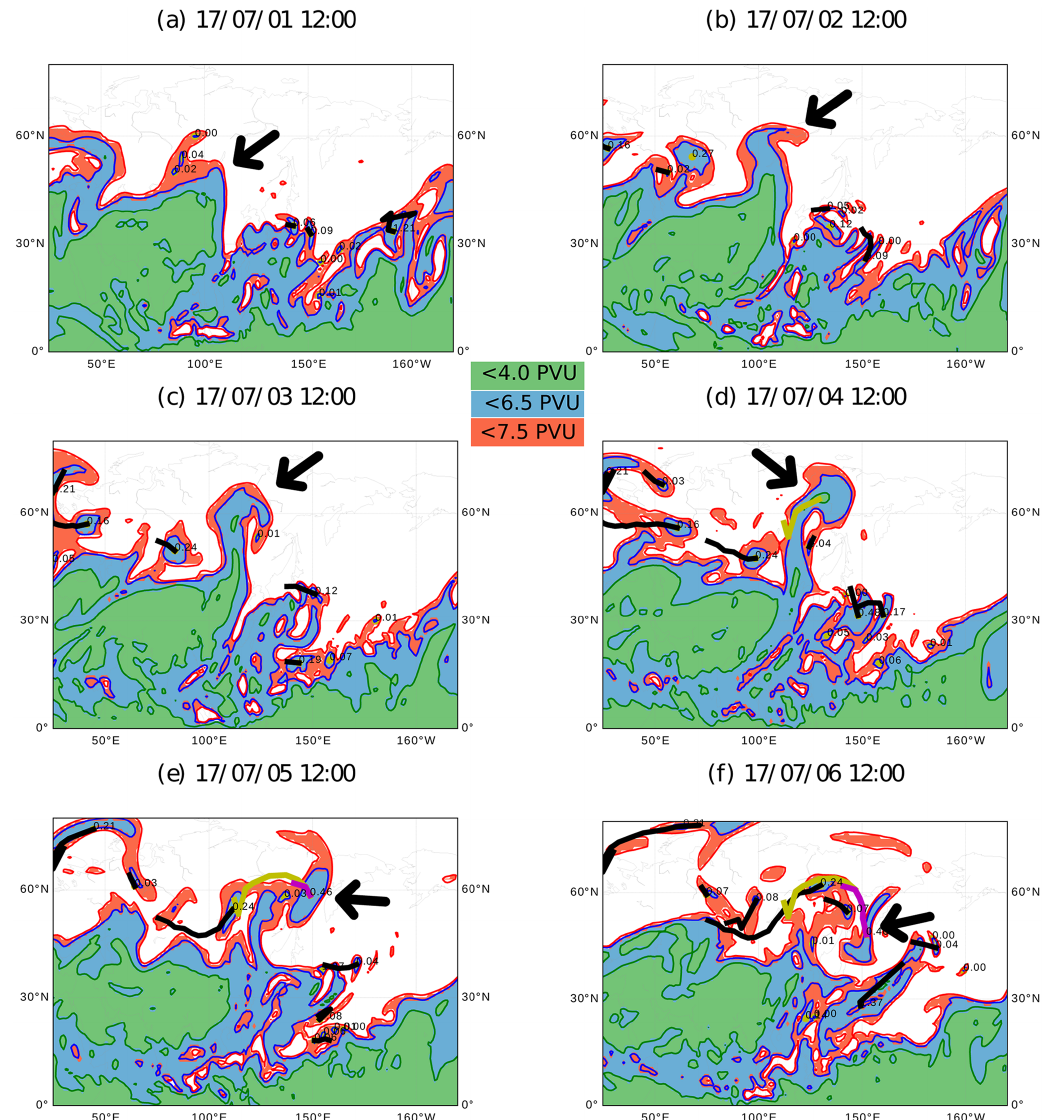
Figure 2. Example of the direct transport pathway from the ASMA into the lower stratosphere by cutoffs at 380K in early July 2017 (see the dates at the top of panels). The black arrows point to the relevant streamers and cutoffs. The track of a small 4.0PVU cutoff is shown in yellow, and the track of the subsequent 6.5PVU cutoff is shown in magenta. The blue area marks the tropical troposphere (PV ≤ 6.5PVU), and the green area marks the ASMA and the equatorial region (PVU ≤ 4.0PVU). Red areas mark the mean tropical tropopause in JJA (June– August; PVU ≤ 7.5PVU). Black lines show tracks of the 6.5PVU cutoffs, and the text shows the maximum size of the cutoff in percent of the Northern